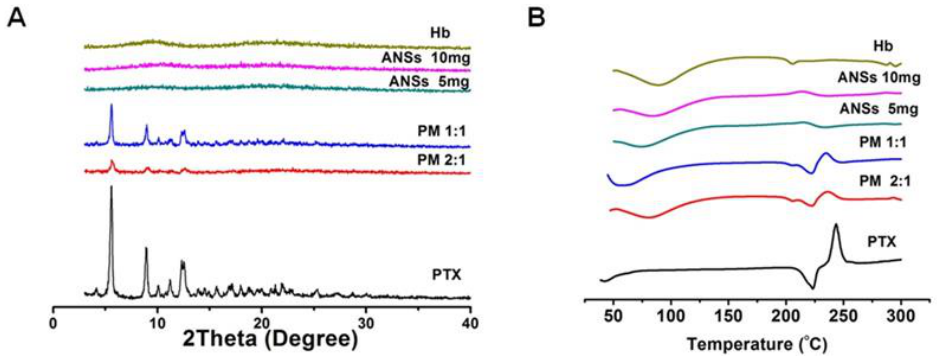
Figure 3. ( A ) Physical state of the drug in ANSs analyzed by PXRD and ( B ) differential scanning calorimetry (DSC). PM 1:1 and 2:1 indicate physical mixture (PM) of Hb/PTX at mass ratios of 1:1 and 2:1.